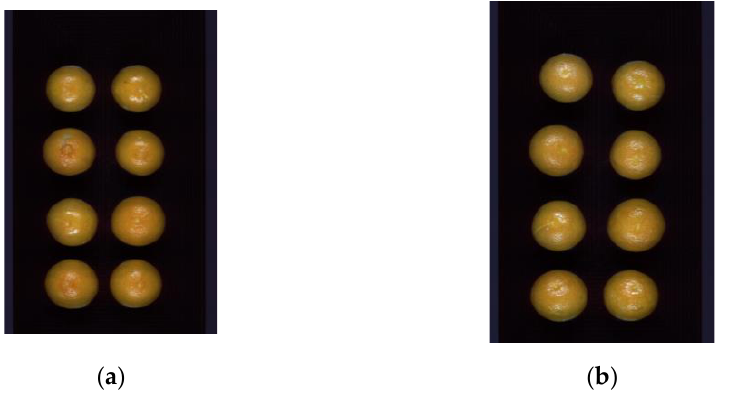
Figure 1. RGB images of Tribute Citru. ( a ): the fruit blossom end; ( b ) the fruit calyx